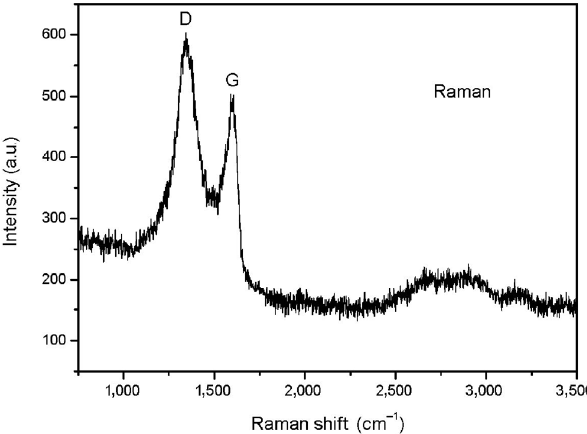
Fig. 16 Raman analysis of the graphene in a wear track of a GO/WC–12Co